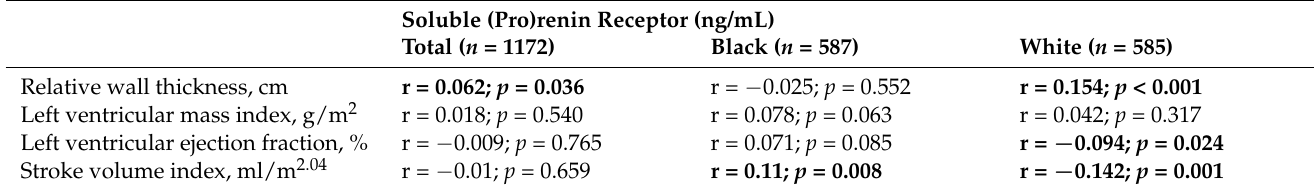
Adjusted for ethnicity, sex and waist circumference. Additionally adjusted for socioeconomic score in the ethnicity- stratified